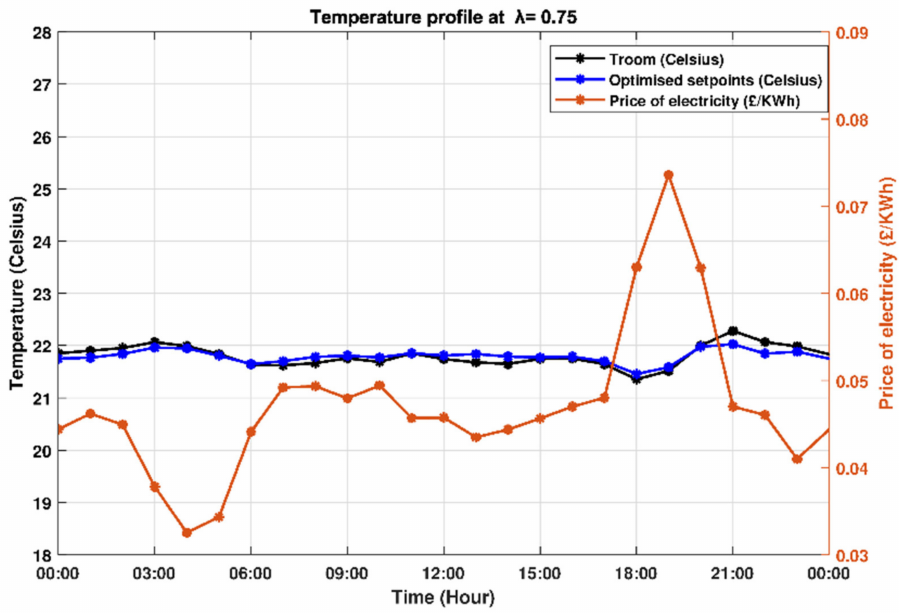
Figure 7. Room temperature and MPC-generated setpoints over 24 h when λ is set to 0.75—indicating a higher preference for thermal comfort with some consideration for energy